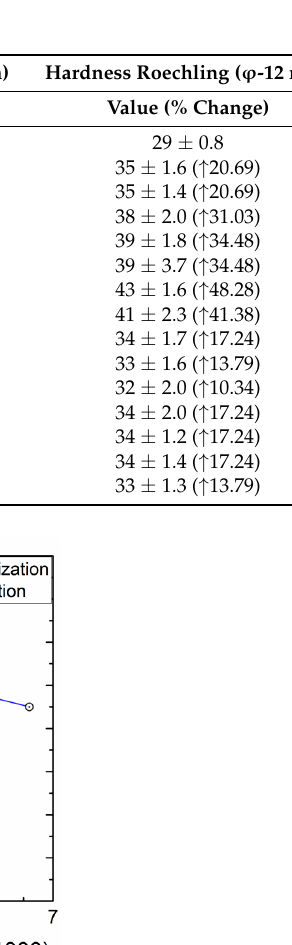
Table 1. Compression force and dimension change results of the clip component in comparison with number of autoclave cycles and test sample’s hardness measurement.